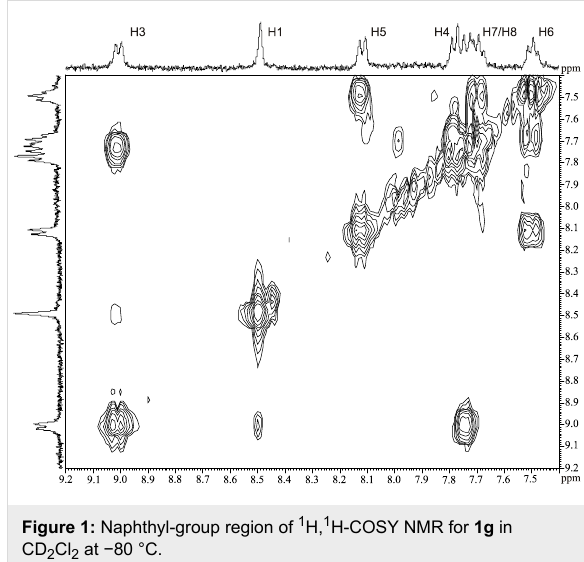
Figure 1: Naphthyl-group region of 1 H, 1 H-COSY NMR for 1g in CD 2 Cl 2 at − 80